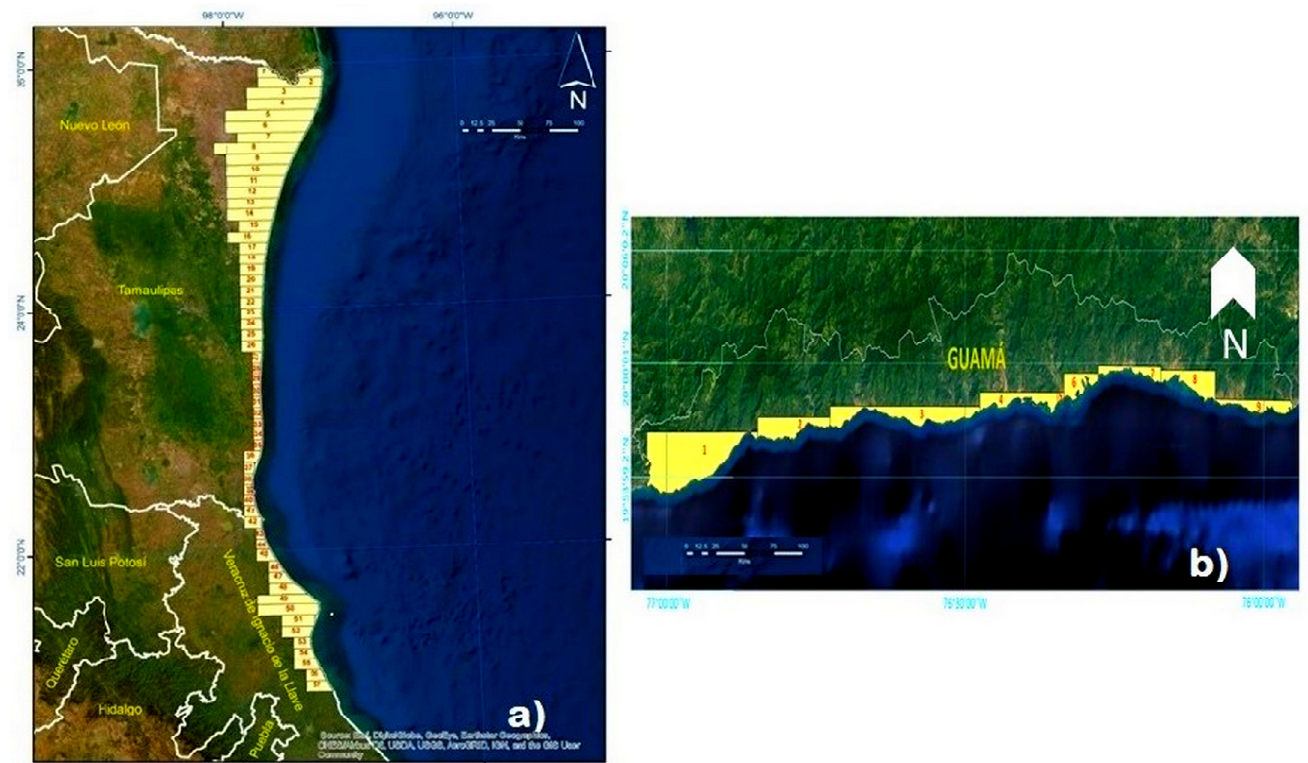
Figure 5. Identification of polygons for the application of the CMI in the study areas. Caption: ( a ) delimitation of the 57 polygons along the coast of Tamaulipas (Mexico) for the determination of the CMI. ( b ) delimitation of the 9 polygons of action along the coast of Guama, Cuba for the determination of the CMI.